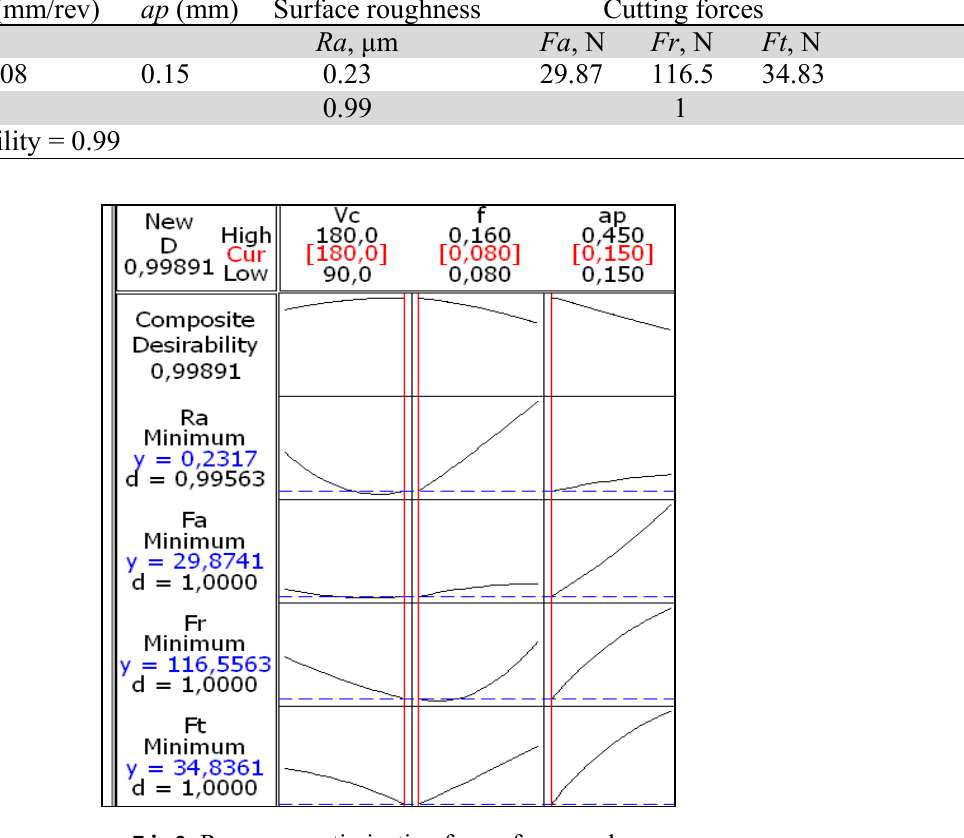
Fig.9. Response optimization for surface roughness and cutting force